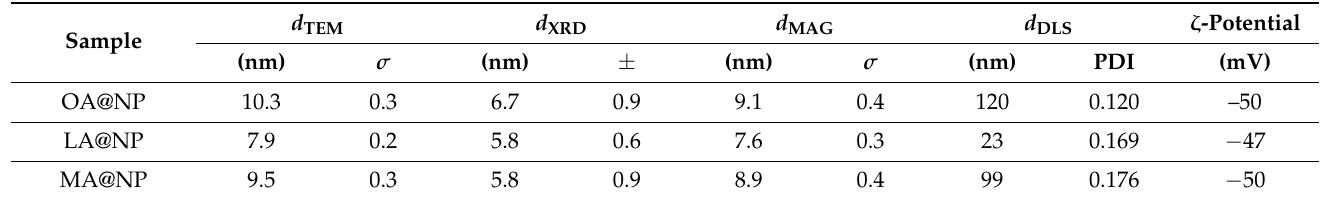
Table 1. Mean particle diameter d TEM by TEM and its standard deviation σ ; average crystallite size d XRD and its uncertainty, magnetic diameter d MAG from the Langevin equation and its standard deviation σ , hydrodynamic diameter d DLS , and its polydispersity index (PDI) and ζ